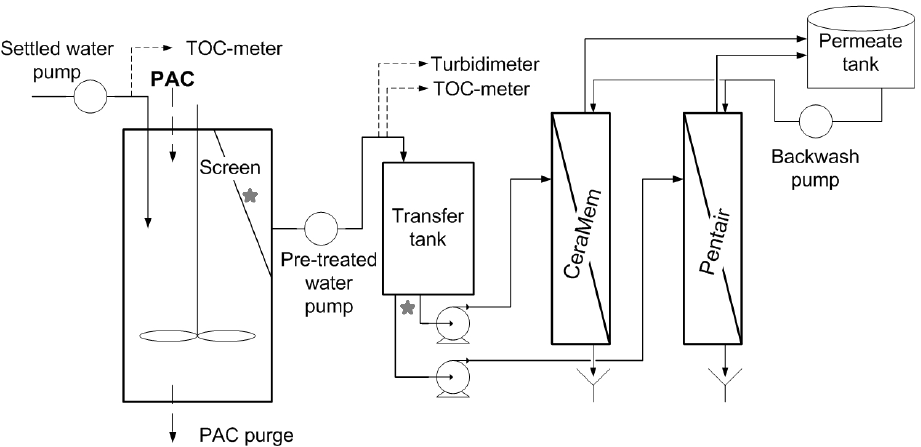
Figure 1. Schematic of the Hybrid Membrane Process (HMP) with powdered activated carbon (PAC) pre-treatment. See Table 2 for design criteria. Stars indicate sampling points used to assess PAC release from the contactor.